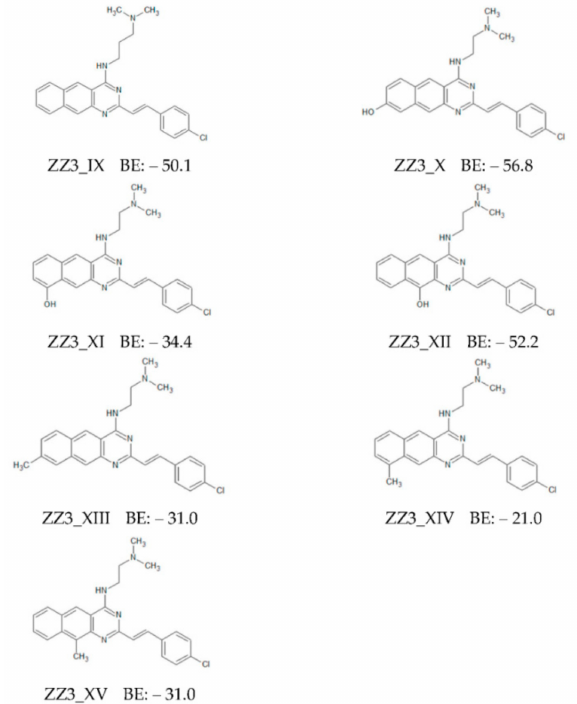
Figure 5. Chemical structures of ZZ3 derivatives with replacing B- or D-part, and their binding energies (BE: kcal / mol) to FtsZ evaluated by ab initio FMO